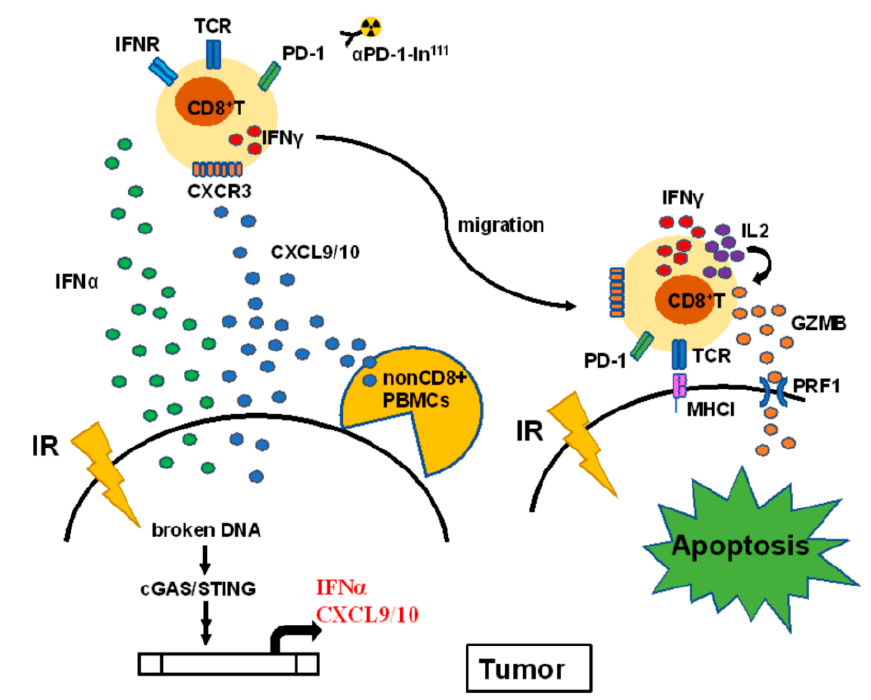
Figure 7. The proposed hypothesis illustrates the potential mechanism of radiotherapy augmenting CD8 + T cells against NSCLC. Irradiation (IR) activates the cGAS-STING signaling pathway through the broken DNA fragments, resulting in IFN α and CXCL9 overexpression and secretion. The secreted cytokines increase IFN γ expression and recruit CD8 + T cells through CXCR3 receptor homing to the tumor microenvironment. The in 111 labeled PD-1-antibody was used to detect CD8 + T cells homing to tumors. CD8 + T cells contact A549 cells to elicit autocrine IL2-mediated GZMB and PRF1 expression, resulting in tumor apoptosis. Particularly, PBMCs co-injected with A549 significantly suppressed tumor growth in the A549-derived tumor xenografts in vivo.